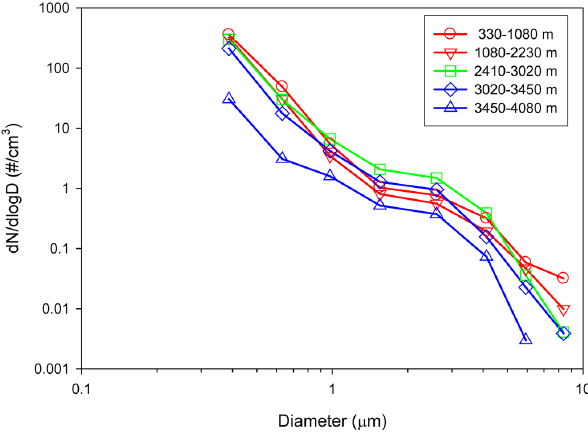
Fig. 6. Number size distributions in classified layers below 4.1km. Data obtained from the OPC sonde, 19 April 2008.